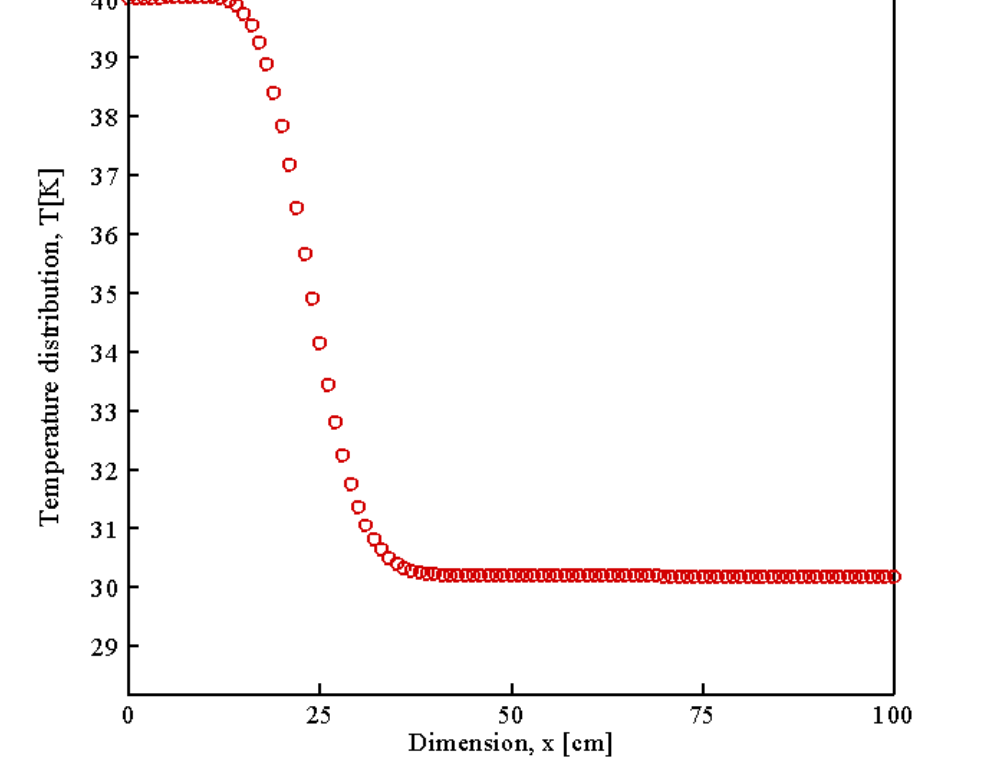
Figure 5. Temperature distribution T versus dimension x at the different thermobaric conditions in the computational domain.